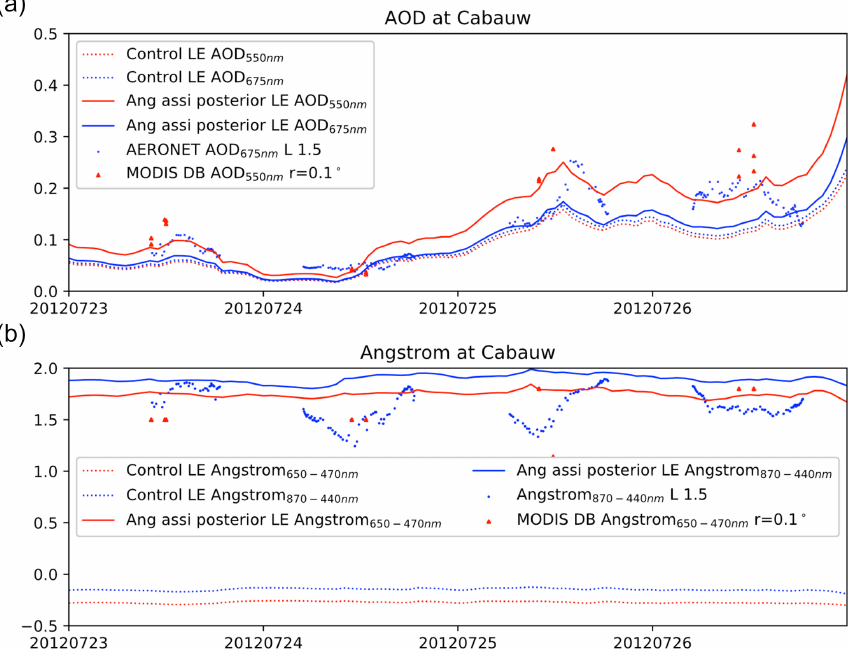
Figure 3. AERONET, MODIS and LOTOS-EUROS prior AOD (a) and Ångström (b) at Cabauw (51 ◦ 58’N, 04 ◦ 55’E). Note that r defines the radius for mapping the MODIS product into test sites. Observations from AERONET and the consistent LE simulations are marked in blue; observations from MODIS and the comparable simulations are shown in red.